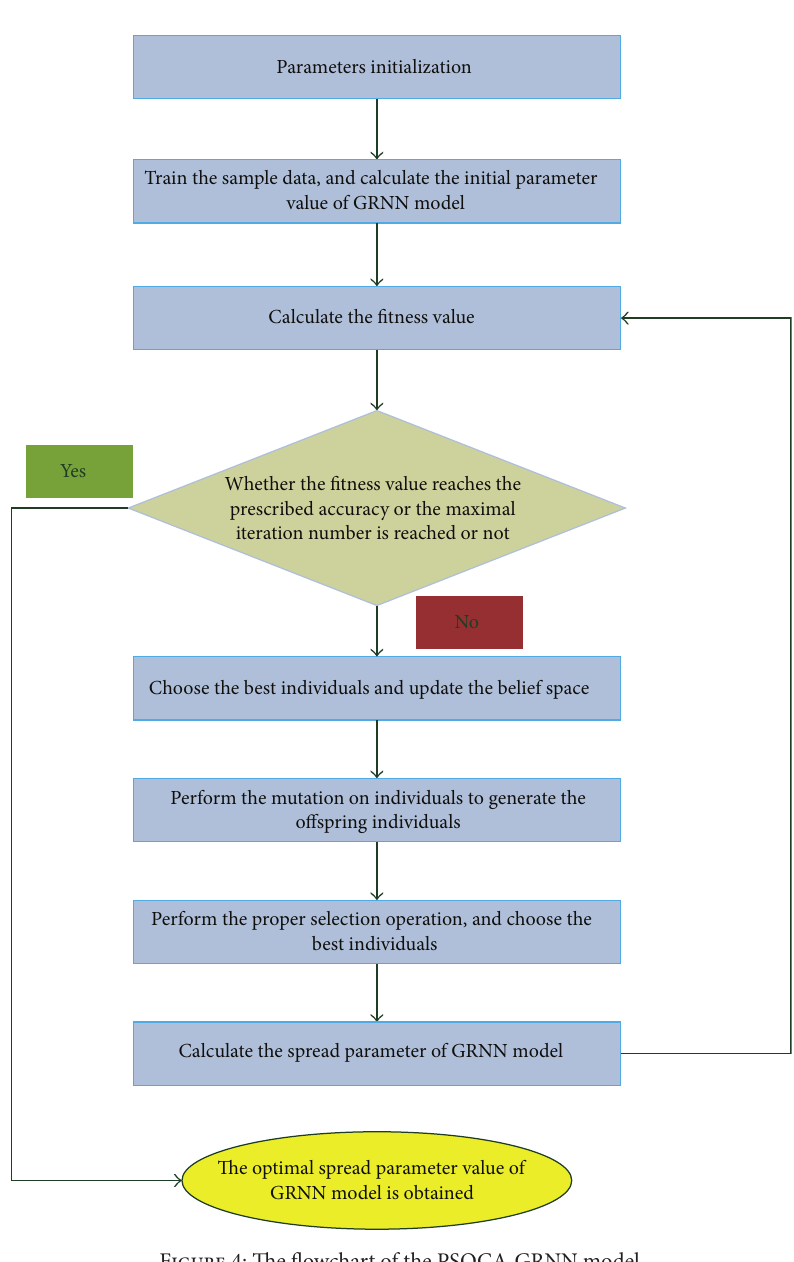
Figure 4: The flowchart of the PSOCA-GRNN model. Table 1: Forecasting results of China’s annual energy consumption from 2005 to 2010 by PSOCA-GRNN, GRNN, PSO-GRNN, DGM (1, 1), and OLS LR